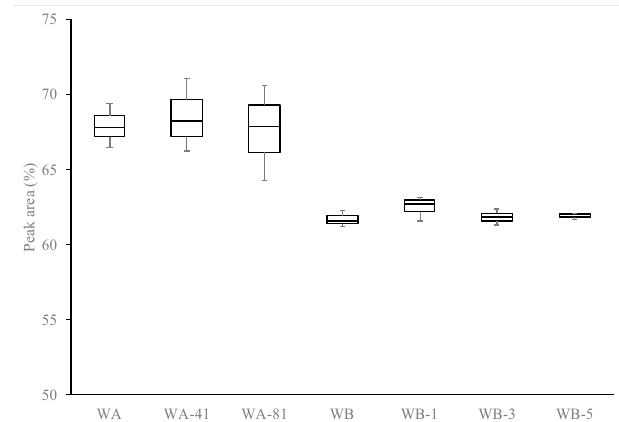
Figure 1. Box-plot of Malvidin-3-monoglucoside percentage on untreated (WA, WB) and sonicated (WA-41, WA-81, WB-1, WB-3, and WB-5) samples. The same results are reported by Zhang et al. [28], who highlighted no changes on malvidin-3-glucoside content in wine samples after 14 and 28 min of sonication.